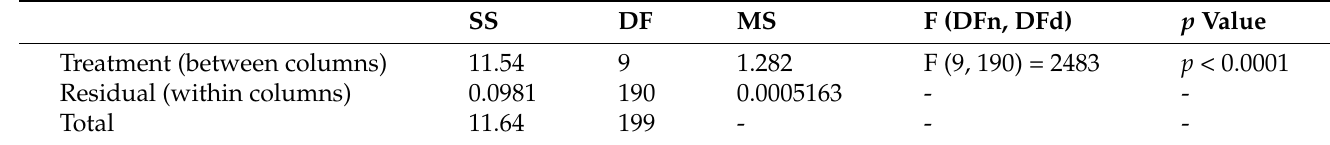
Table 18. ANOVA test results for the GSDTO’s parameters of Convergence time and Fitness.